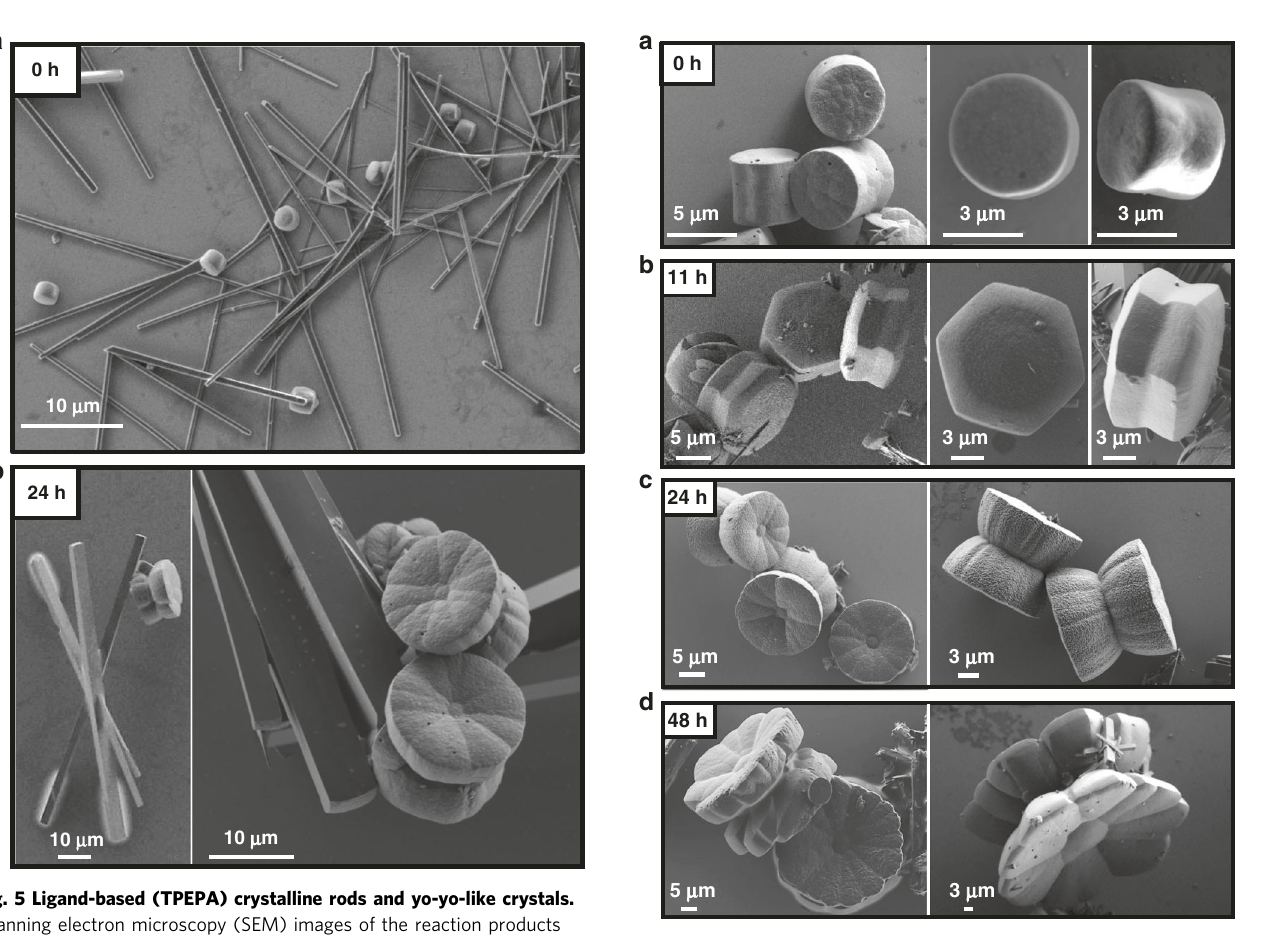
Single-crystal X-ray diffraction (SXRD) . SXRDs were collected both by syn- chrotron source at the Beamline ID-29 of European Synchrotron Radiation Facility (ESRF) and by a Rigaku XtaLabPro X-ray diffractometer. The Rigaku XtaLabPro X-ray diffractometer is equipped with a 4-circle Kappa goniometer, a Dectris Pilatus 3R 200K-A detector, and a micro-focus sealed tube with microCMF-VHF. The data were collected with λ = 0.700Å (syncrhroton) and CuK α 1 radiation, λ = 1.5418 Å (Rigaku XtaLabPro diffractometer). The Rigaku XtaLabPro instrument presents a micro-focus beam with a 100 μ m beam; such a beam is large enough to